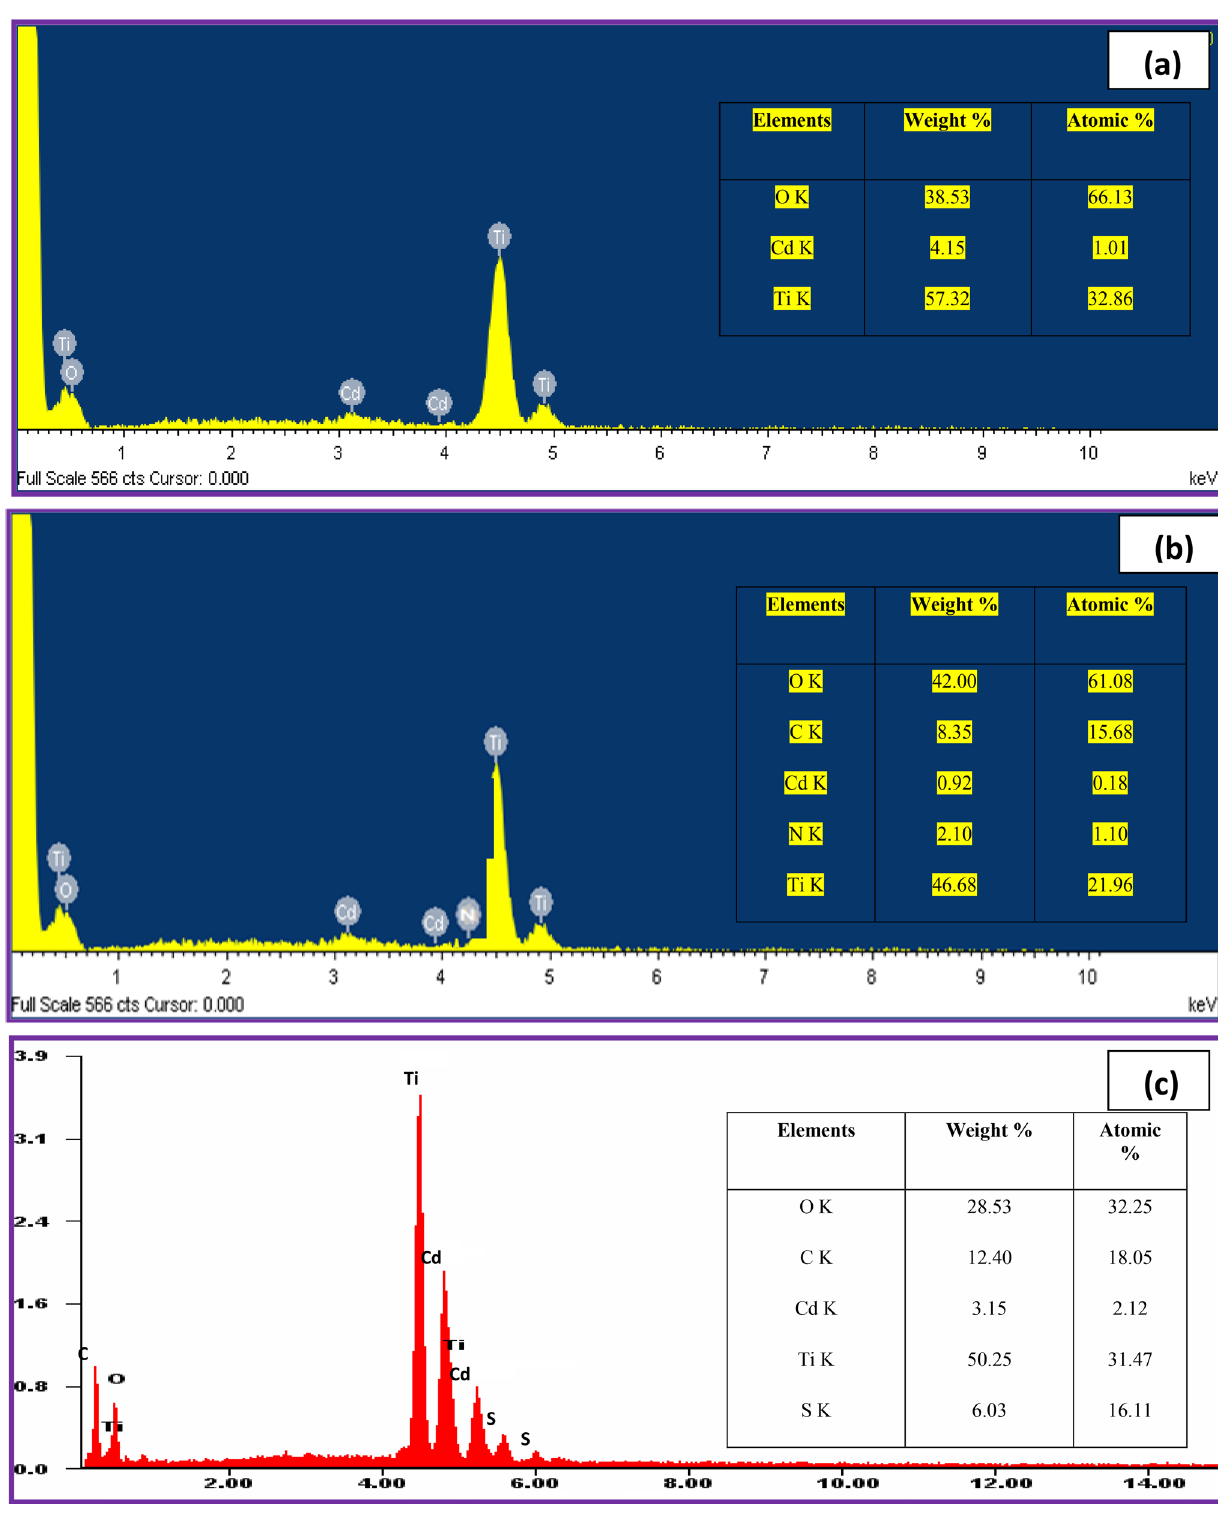
Figure 4. EDX of ( a ) CT ( b ) CS-CT and ( c ) AS-CT